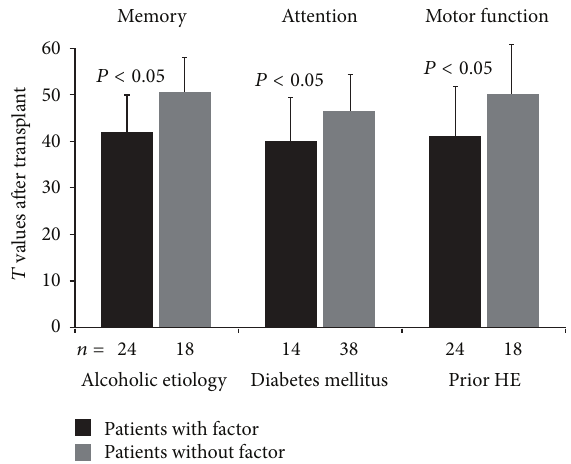
Figure 2: Posttransplant cognitive function ( 𝑇 values) in patients with or without risk factors that were determined to be associated with cognitive impairment (i.e., cirrhosis of alcoholic etiology, diabetes mellitus, and prior HE). 𝑇 values were calculated using the following formula: 𝑇 = 50 + 10 ( [ raw test value − mean test value ] /SD of normal population). Impairment was defined as 𝑇 ≤ 40 . HE, hepatic encephalopathy; SD, standard deviation. Adapted with permission from Garcia-Martinez et al., Copyright © 2011 American Association for the Study of Liver Diseases